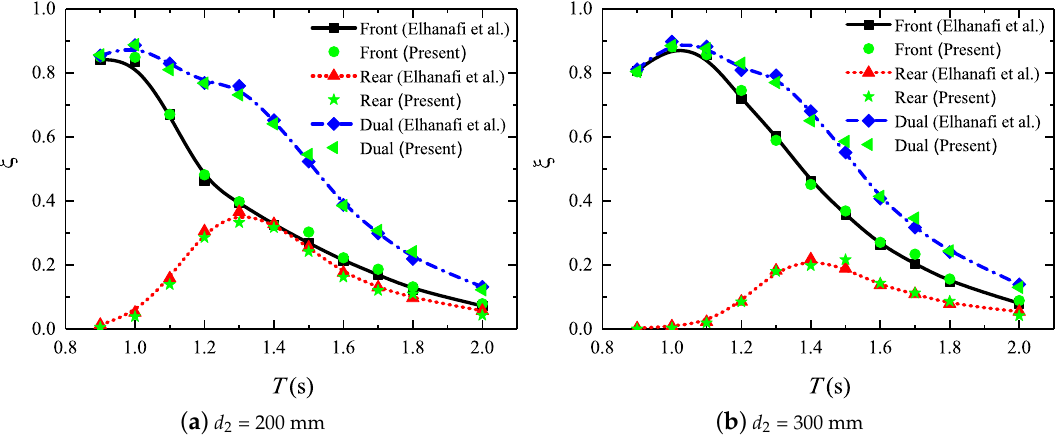
Figure 7. Comparison of wave energy conversion efficiency ξ between the present and [18]’s